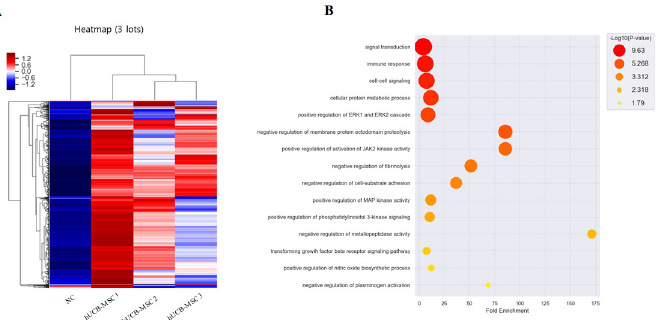
Fig 4. L-1000 analysis of cell culture supernatants of hUCB-MSCs for identification of secreted protein about regulating RA. (A) Heatmap analysis of genes in three samples after treatment with hUCB-MSCs analyzed by L-1000 using MEV program. Colors of columns represent relative abundances. Columns indicate the abundance with different colors as indicated in the legend (blue, lower abundance; red, higher abundance). (B) GO terms in the enrichment analysis of genes affected by hUCB-MSCs. Higher significance is indicated by red and lower significance is indicated by yellow as described in the legend. The position of the circle changes according to fold enrichment.